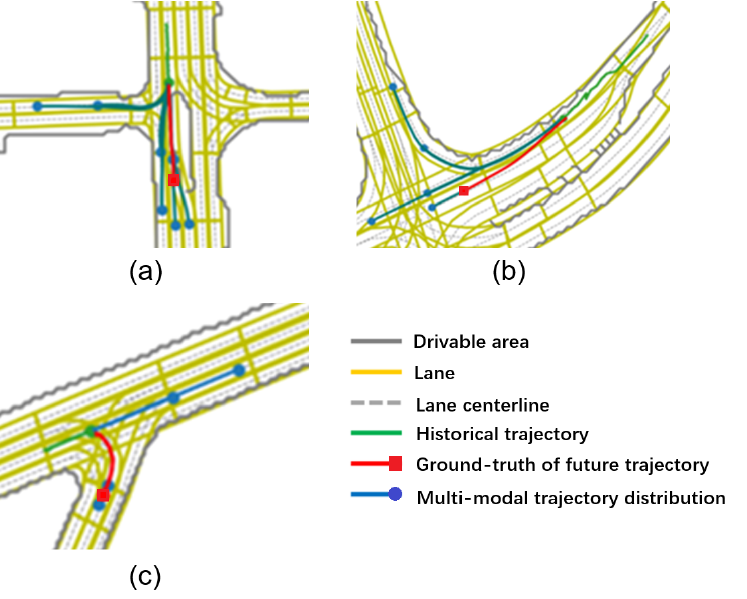
Figure 5. Visualization of multi-modal prediction results in different urban road scenarios (which can be better viewed in color). ( a ) Prediction at intersection. ( b ) Prediction at T-junction. ( c ) Prediction at merging.